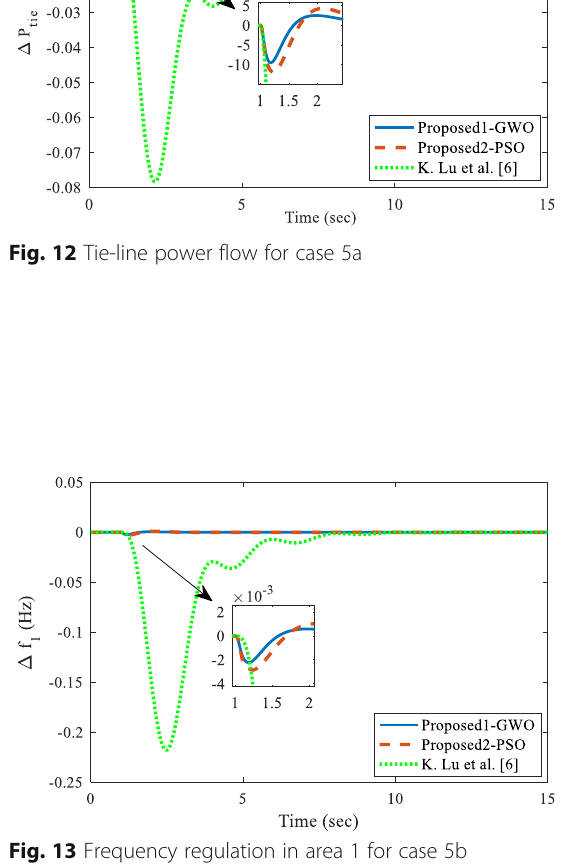
Fig. 16 Frequency regulation in area 1 for case 5c